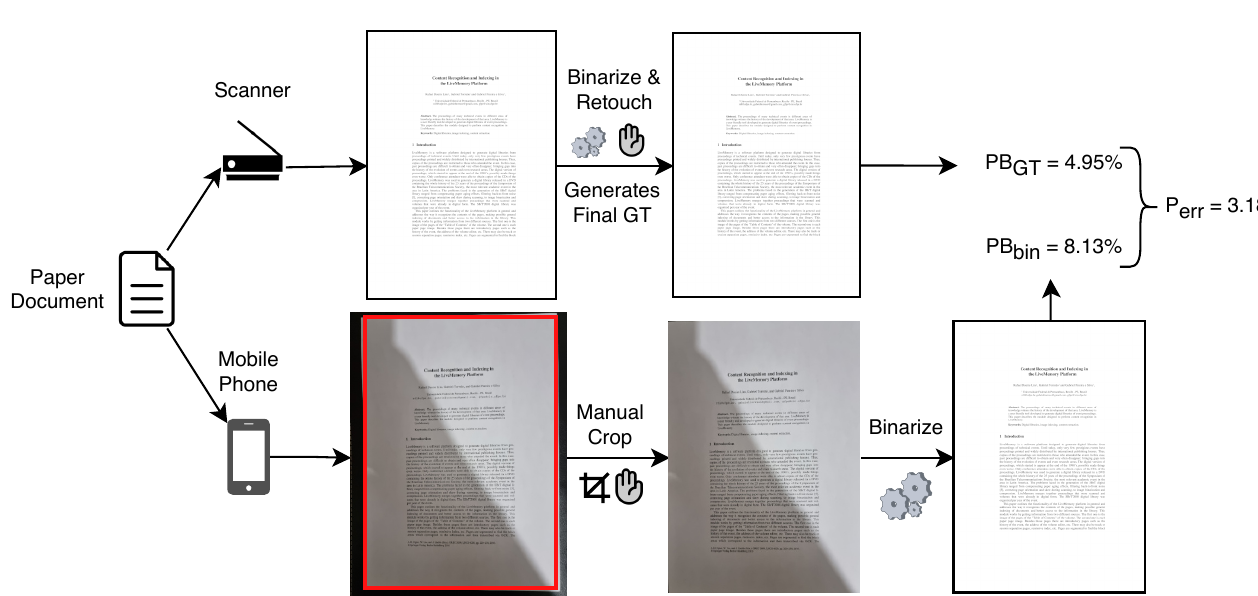
Figure 1. P err measure example (GT: ground-truth, bin: